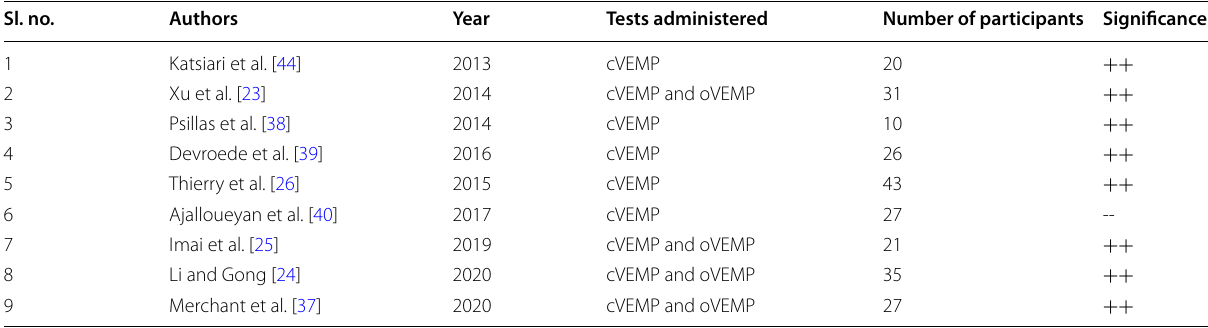
significant difference in any of the cVEMP/oVEMP test parameters between the children with normal hearing and with SNHL using a cochlear implant ++ -- non-significant difference between cVEMP and oVEMP test parameters between the children with normal hearing and with SNHL using a cochlear implant